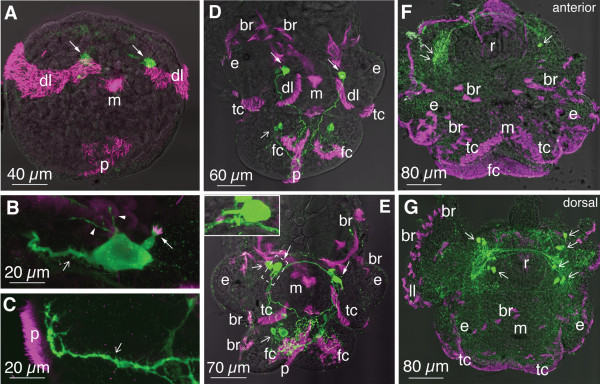
Development of ciliary structures and serotonergic system in H. trivolvis. Anti-α-tubulin (magenta) and anti-5-HT (green) immunostainings were imaged in a laser confocal microscope. In A and D-G, confocal images were combined with transmission light images. (A-C) Early trochophore (stage 19). (A) Two apical neurons (arrows), dorsolateral (dl) and pedal (p) ciliary bands are present. (B) Higher magnification of the apical neuron with dendritic knob, which bears short cilia (arrow), thin back branches (arrowheads), and primary neurite (open arrow). (C) Primary neurite (open arrow) with numerous thin branches underneath the pedal band of cilia (p). (D) Middle veliger in the beginning of metamorphosis (stage 23). Dorsolateral and pedal ciliary bands are complemented by foot ciliary fields (fc), tentacle ciliary fields (tc) and numerous body wall ciliary brushes (br). Two apical 5-HT neurons (arrows) and 5-HT positive cells within cerebral and pedal ganglia (open arrows) are present. (E) veliconcha in the middle of metamorphosis (stage 25). Dorsolateral ciliary bands are not visible, whereas all other ciliary structures are present. Insert, high magnification of the apical 5-HT neuron with ciliated dendritic knob. (F, G)H. trivolvis at the end of metamorphosis (stage 27), anterior (F) and dorsal (G) view. Serotonin-immunostaining is present in neurons of central ganglia (open arrows) and their peripheral processes only. Foot and tentacle ciliary fields (fc, tc) and numerous body wall ciliary brushes (br) are present. Note that 5-HT-immunopositive apical neurons, cilia on their dendritic knobs as well as dorsolateral and pedal ciliary bands are not visible. ll – lung lobe, m – mouth, e – eye, r – radular sack.